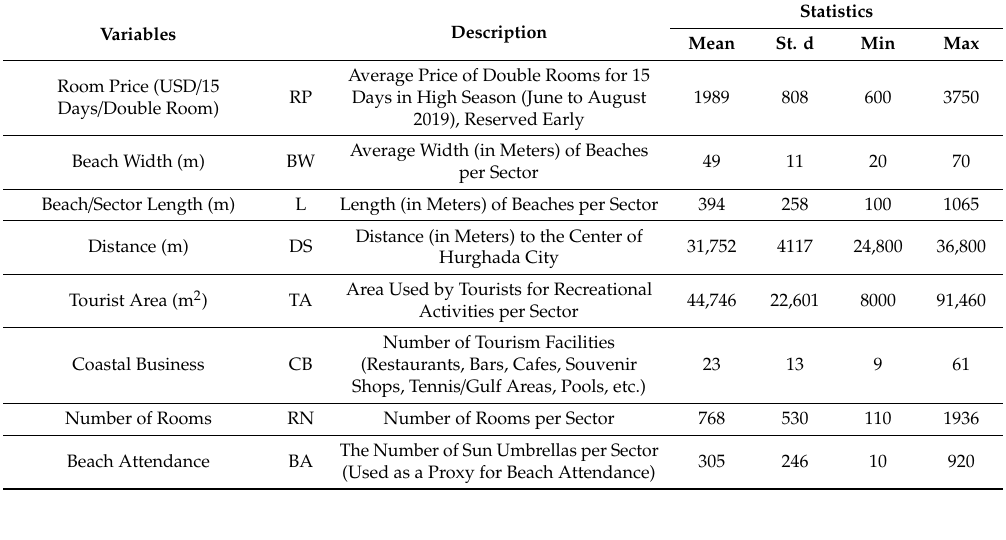
Table 1. Hedonic pricing variables, description, and statistical summary.